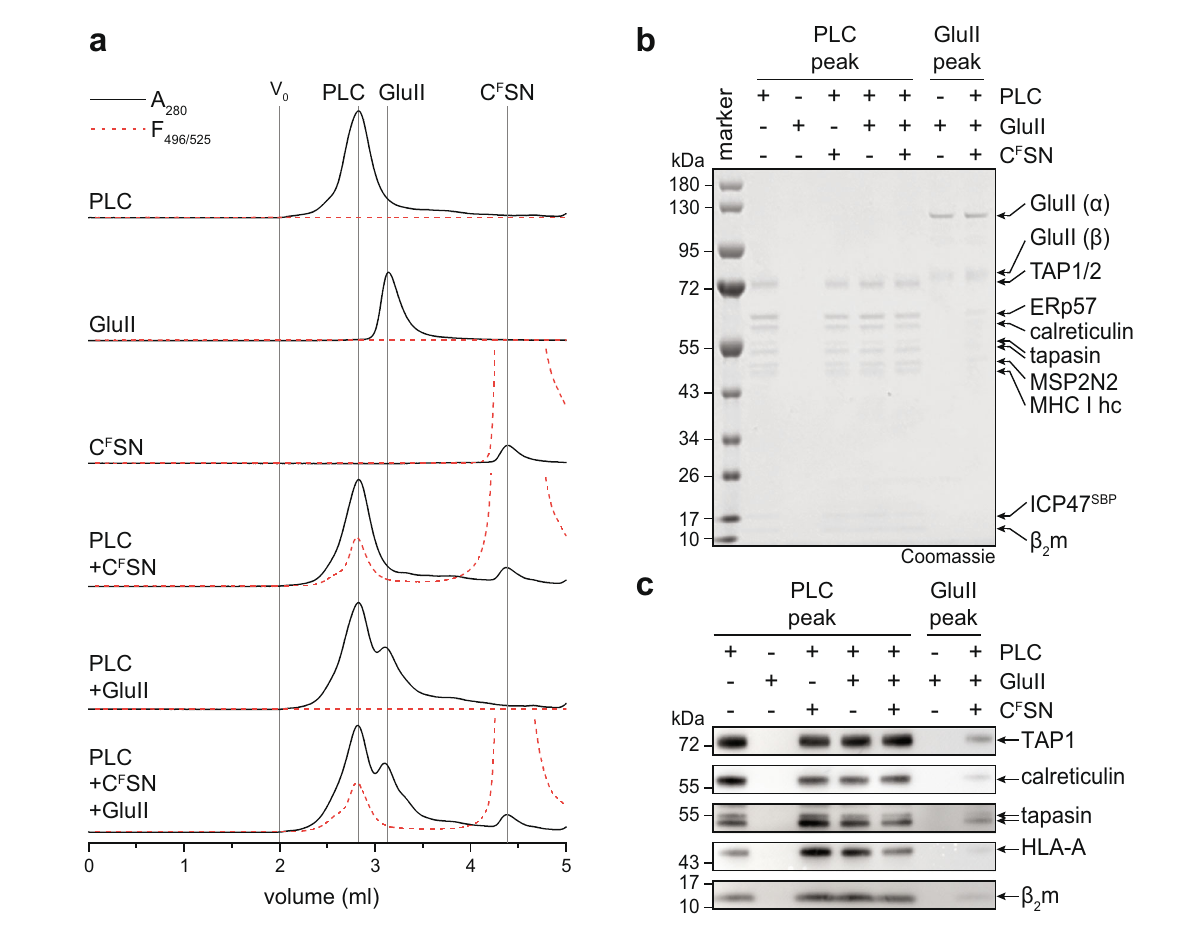
peptide epitope (CSN) and GluII-catalyzed deglucosylation of MHC I, as demon- stratedbySDS-PAGE( b )andimmunoblotting( c )ofSECfractionscorrespondingto the PLC and GluII peak. The data are representative of two biological replicas. Source data are provided as a Source Data fi